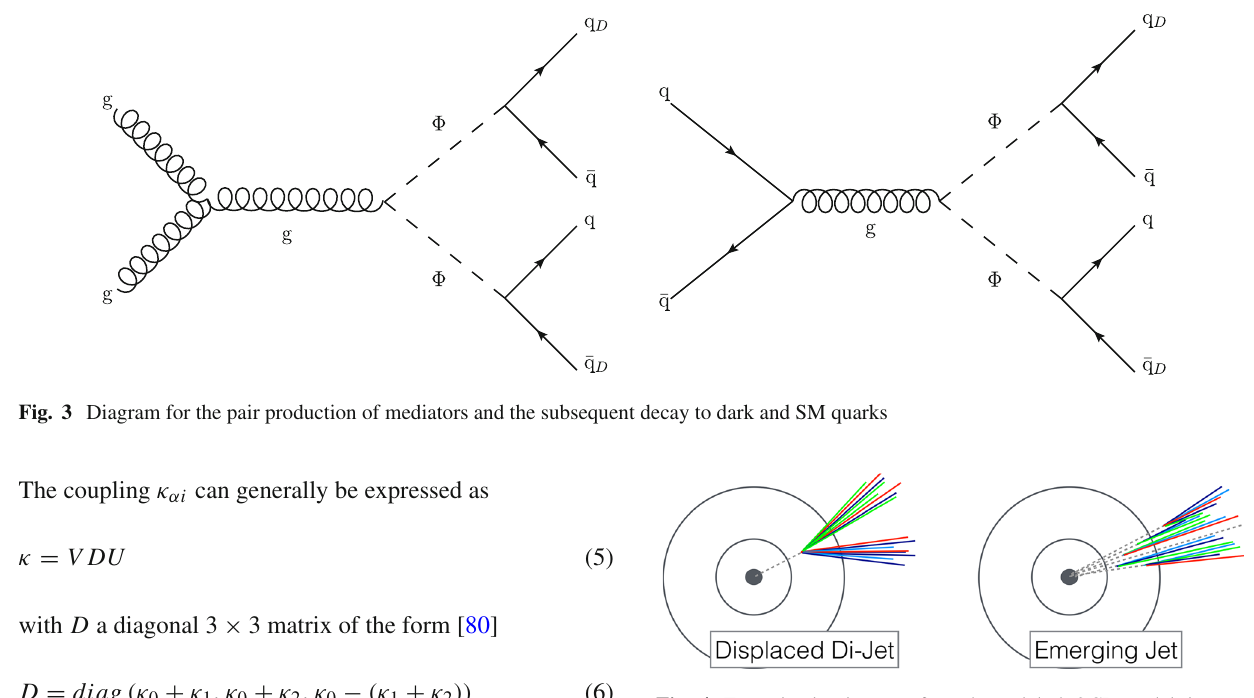
Fig. 4 Emerging jet signature for t-channel dark QCD models in com- parison to the displaced dijet signature. Figure taken from